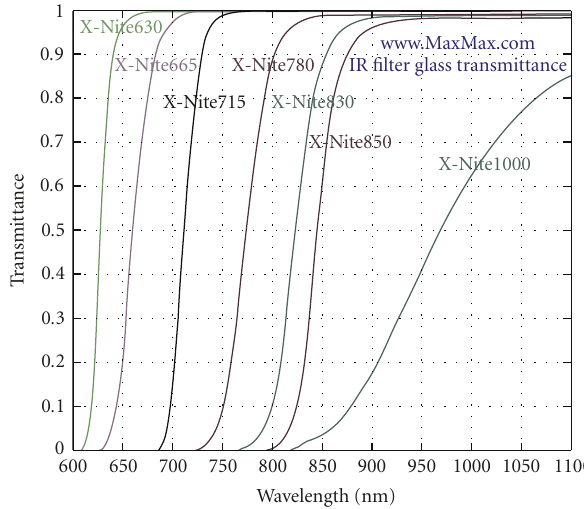
Figure 5: Transmittance of various filters. The graph shows the various IR filters available, out of which X-Nite715, X-Nite780, X- Nite830, and X-Nite1000 were tested for use with the proposed system. It was found that the acquired images were suitable for iris matching when using the X-Nite715 filter. The source of the graph is